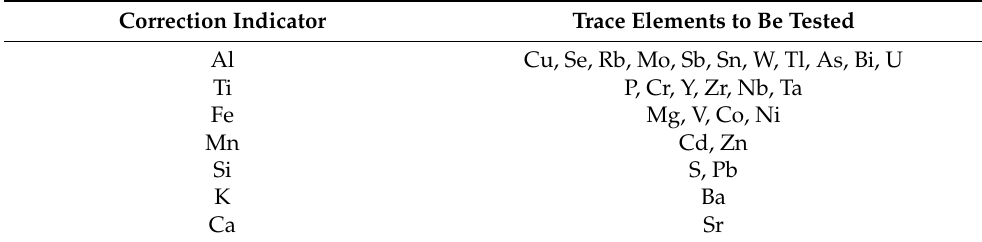
Table 2. Correction indicators for elements to be tested by pXRF analysis.